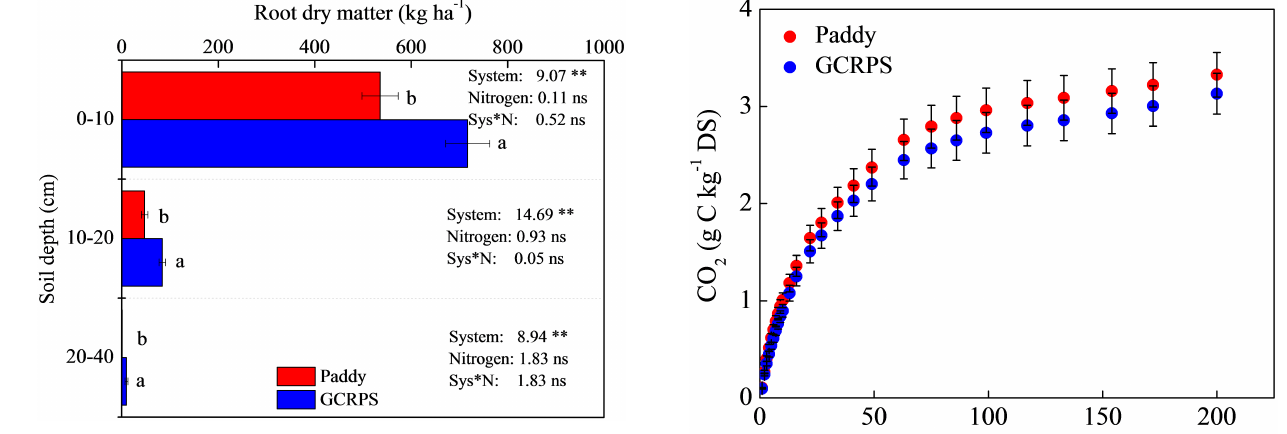
Figure 4. Root dry matter at maximum tillering stage for different soil depths in traditional paddy fields and GCRPS. n is 18 and er- ror bars denote SEM. Bars labeled with different lowercase letters indicate differences ( P <0.05) between paddy sites and GCRPS.